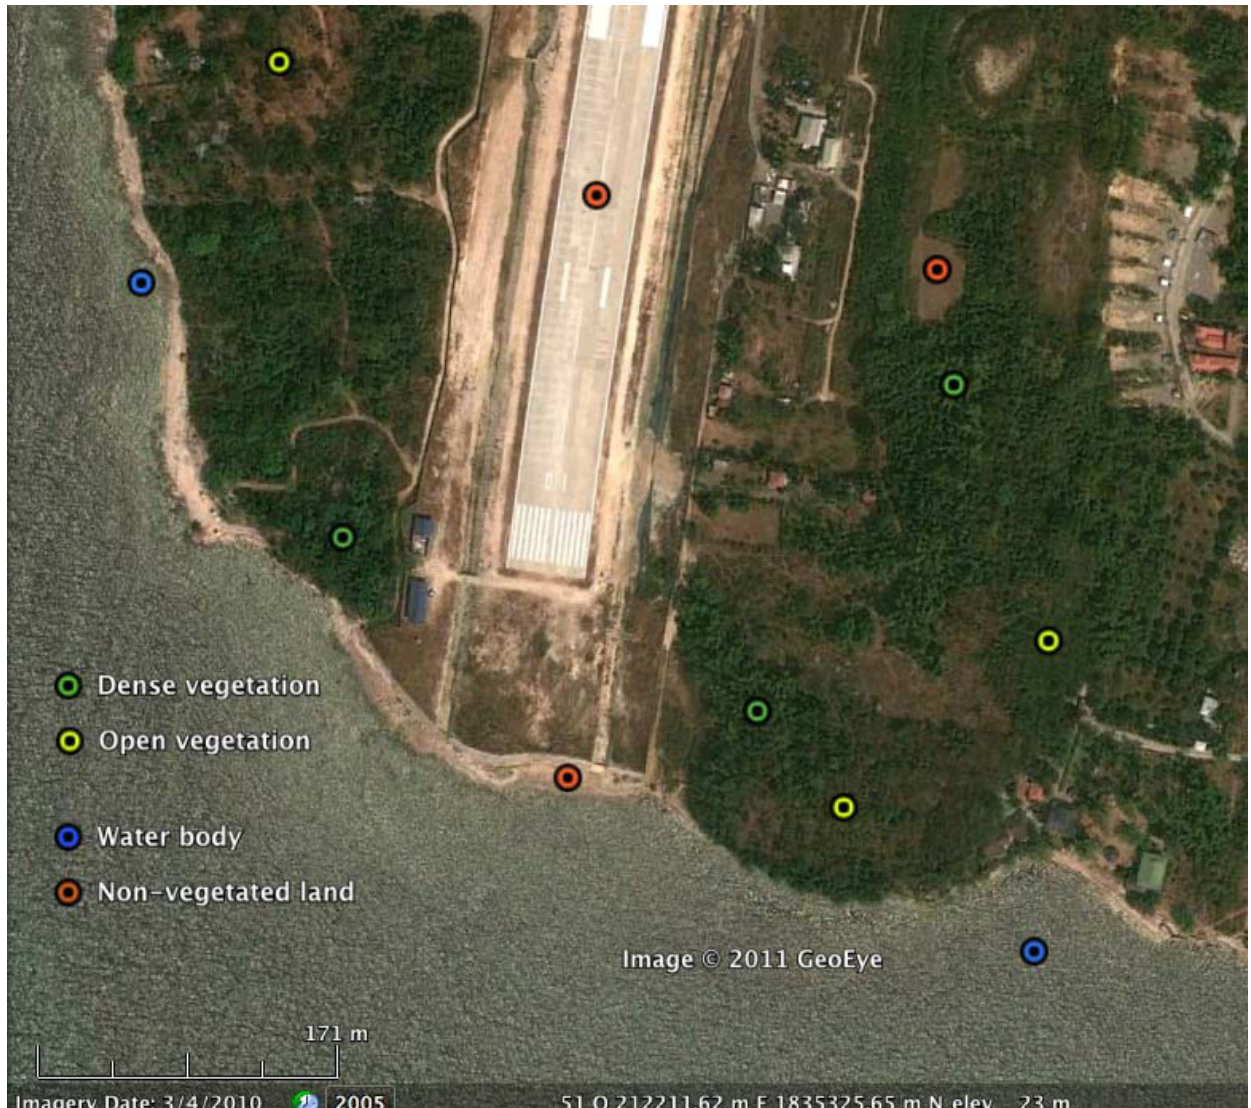
Figure 2. Visual representation of the land cover classification scheme. The figure covers a part of Barangay Canaoay (see Figure 1). This image is a 2010 GeoEye-1 satellite image used as a reference. Source: Google